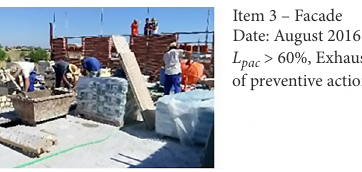
Figure 6. Images of the construction development of the work